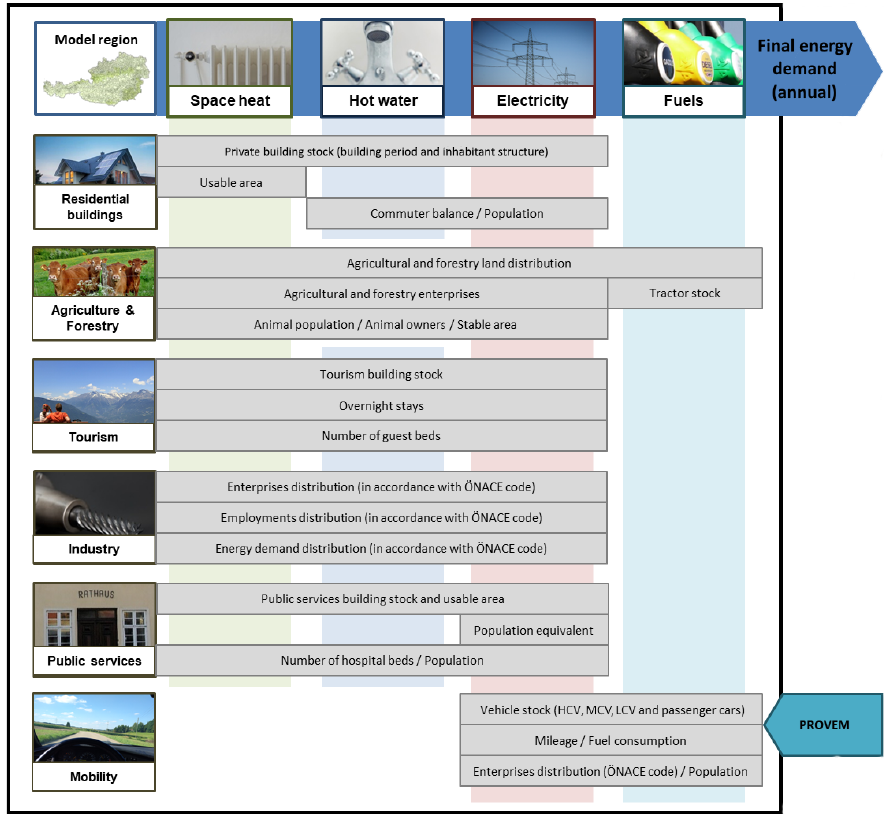
Figure 2. Methodology for calculation of final energy demand for municipalities. The final energy demand in the residential building sector is based on the inhabitant structure, building period, commuter balance, population, and specific energy demands, which could be defined as a classic bottom-up approach. The public services sector is con- sidered similarly to the residential building sector based on a bottom-up approach related to the usable area. Exemptions are hospitals and sewage sludge plants. The bottom-up approach within the sewage treatment sector refers to the population equivalent, the de- sign basis for sewage treatment plants. The use of hospital bed numbers calculates the energy demand for hospitals. A mixed approach calculates the energy demand of the ag- riculture and forestry sector. Therefore, the heat and electricity demand is proportional to the agricultural and forestry land distribution, animal population, and the number of an- imal owners for the municipality in the dedicated state. The fuel demand is determined by the land distribution of the municipality and specific fuel demands per agricultural land. The energy demand within the tourism sector is calculated using a bottom-up ap- proach based on tourism building stock and the number of seasonal guest beds, with re- lated specific energy demands. The primary and secondary industry sectors, such as the manufacturing goods or construction sectors, are based on a top-down approach accord- ing to different frameworks for the related state. The tertiary industry sectors, such as trading enterprises, are based on a bottom-up approach.